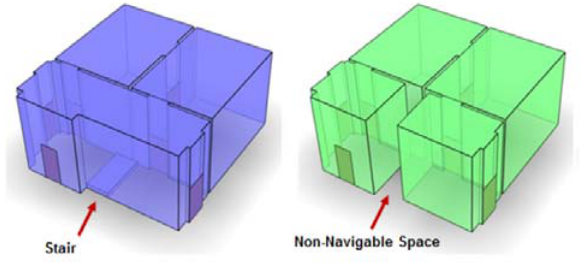
Figure 3. Multi-Layered Space Model (OGC 2010)